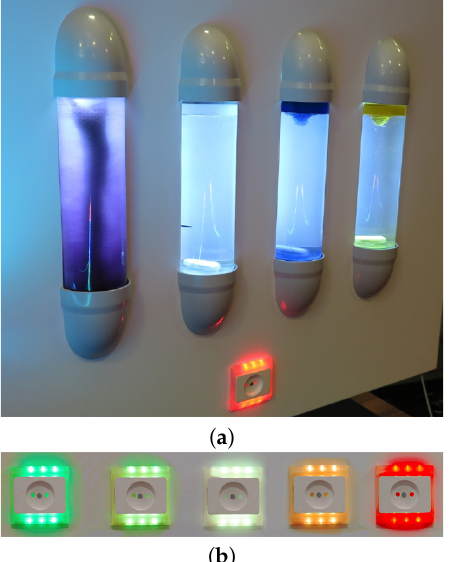
Figure 16. Colored glass pipes used in Watt-I-See to show different energy sources ( a ), and the colored power sockets ( b ). Images from Reference